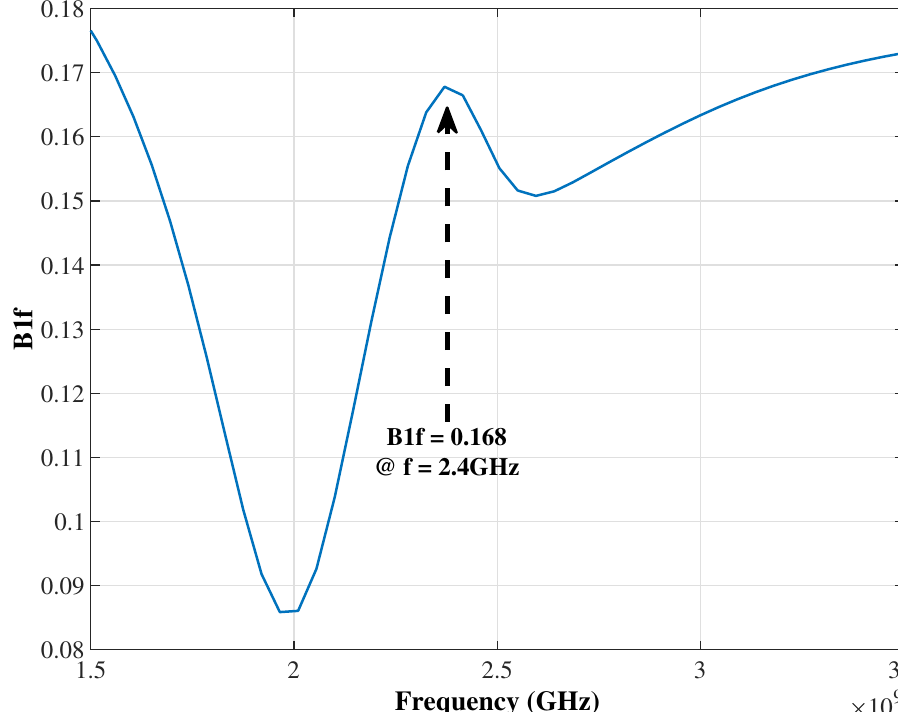
Figure 8. B1f vs. frequency for Stability test.